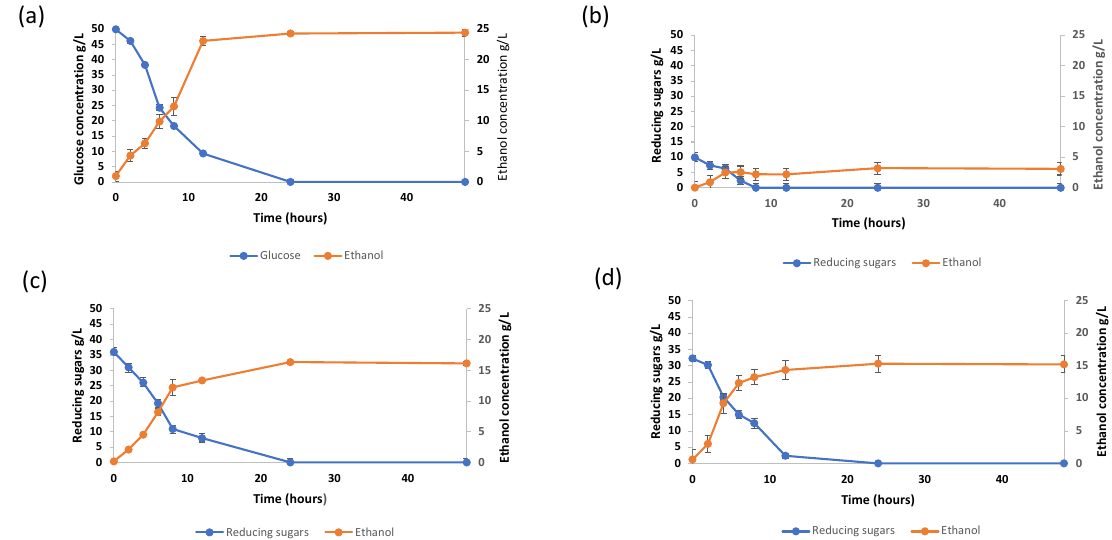
Figure 2. Evolution of ethanol and reducing sugar concentrations (g/L) during fermentation for the four samples studied: ( a ) glucose, ( b ) unhydrolyzed argan pulp, ( c ) argan pulp hydrolyzed using Viscozyme, and ( d ) argan pulp hydrolyzed using Celluclast.